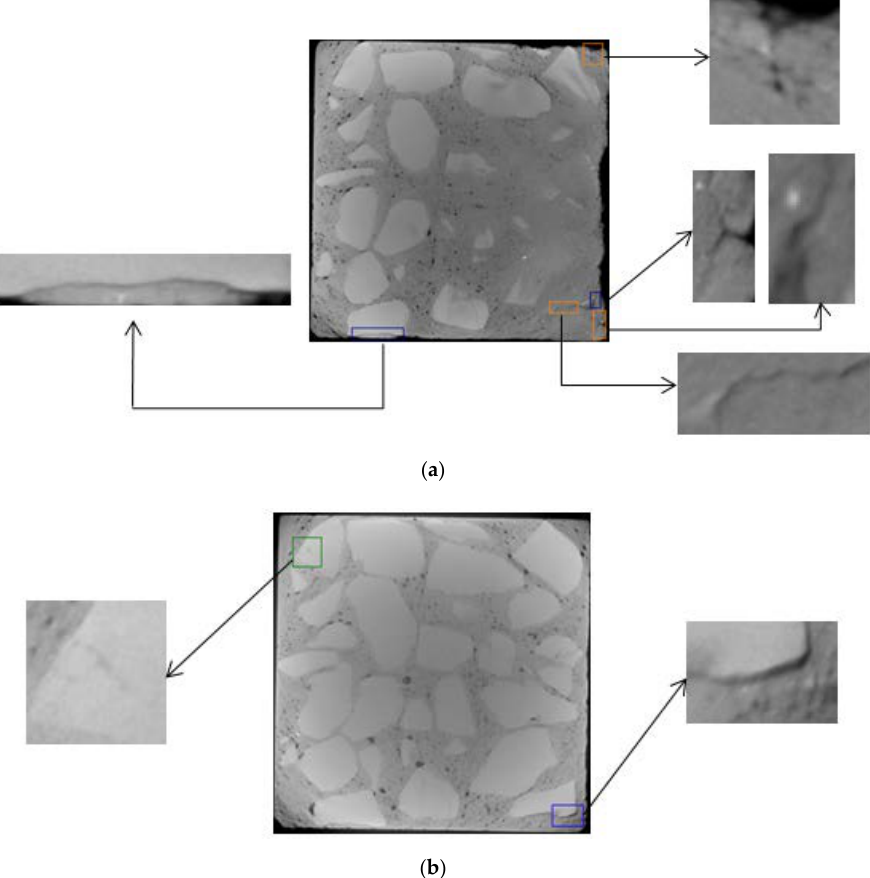
Figure 7. Crack propagation images of D5 under 80 dry–wet cycles of sulfate attack: ( a ) surface layer; ( b ) inner layer.